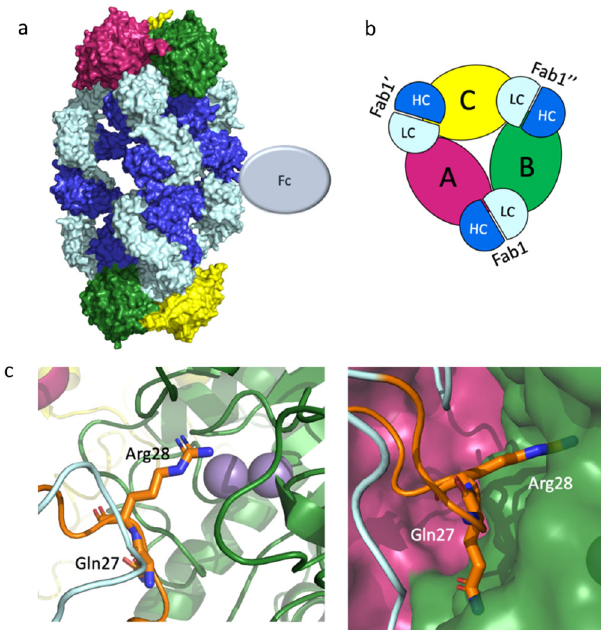
Fig. 4 Overall complex formation and epitope mapping for mAb4 2:3 complex. a An overview of the 2:3 hArg1:mAb4 complex assembly. The three monomers of the hArg1 trimer colored in green, pink, and yellow, and the mAbs colored in bright blue (heavy chain) and pale blue (light chain). The full complex is shown in surface representation. b Half of the complex in cartoon form is viewed from the top down for ease of interpretation. Here it is apparent that each HC interacts with only one hArg1 monomer, while each LC interacts with two hArg1 monomers. These interactions are symmetric around the trimer. c In this mAb, the CDR-1 loop of the LC (orange) is in close proximity to the hArg1 active site with Arg28 (sticks) extending into the binding pocket. Gln27 (sticks) occupies additional space on the outer surface of the active site. The binuclear active site manganese ions are shown as purple surface-based steric occlusion instead of requiring full active site in fi ltration.